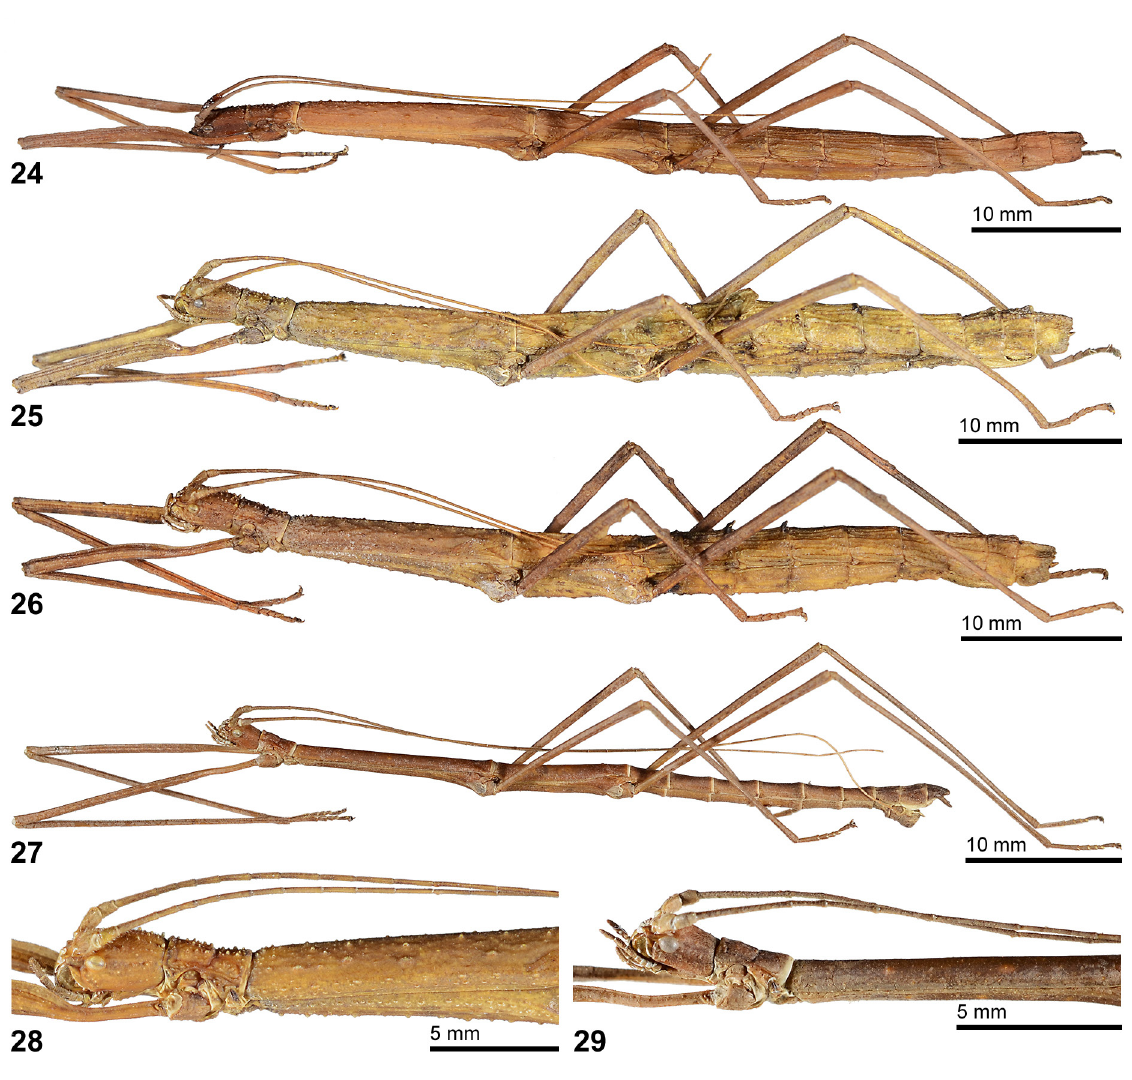
Figs 24–29. Lobolibethra pozuzoae sp. nov. 24 . ♀, PT (FH, 0631-2). 25 . ♀, PT (FH, 0631-42). 26 . ♀, PT (FH, 0631-44). 27 . ♂, PT (FH, 0631-51). 28 . ♀, PT: detail of head and thorax in lateral view (FH, 0631-35). 29 . ♂, PT: detail of head and thorax in lateral view (FH,